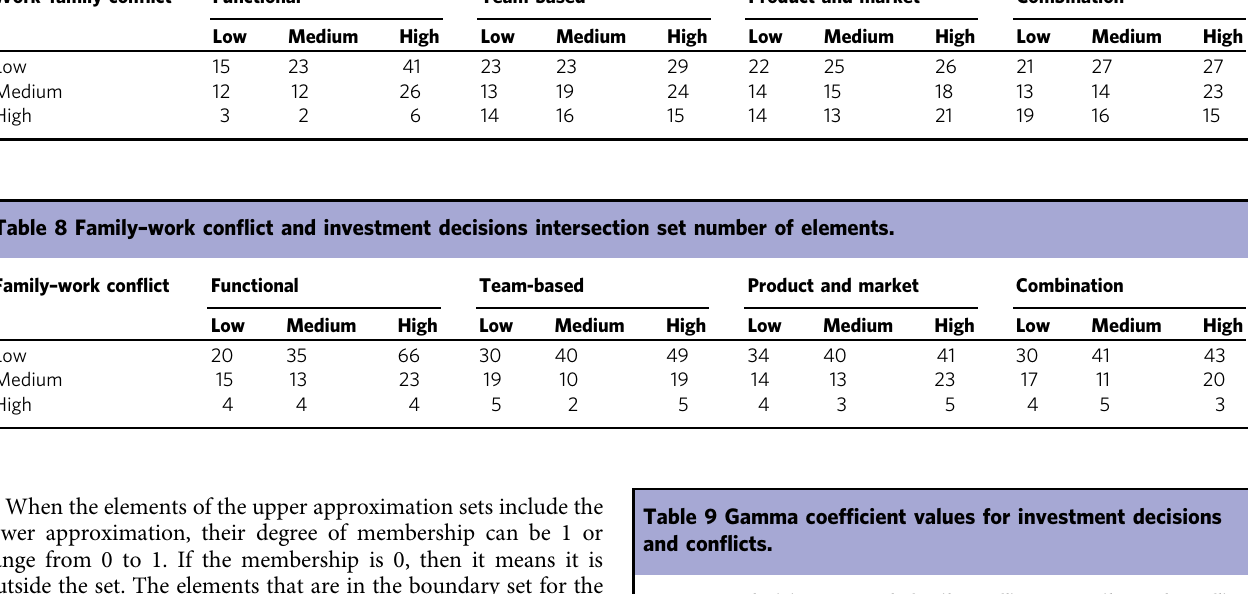
Table 7 Work – family con fl ict and investment decisions intersection set number of elements. Work – family con fl ict